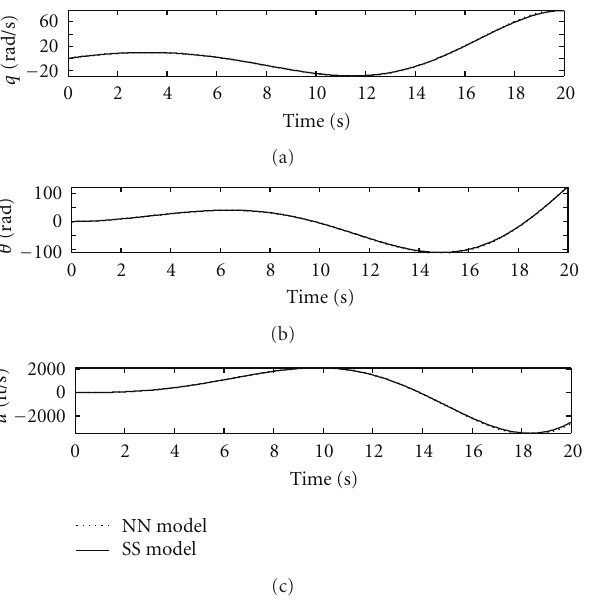
Figure 3: NN versus state-space models for helicopter dynamics described by (6).